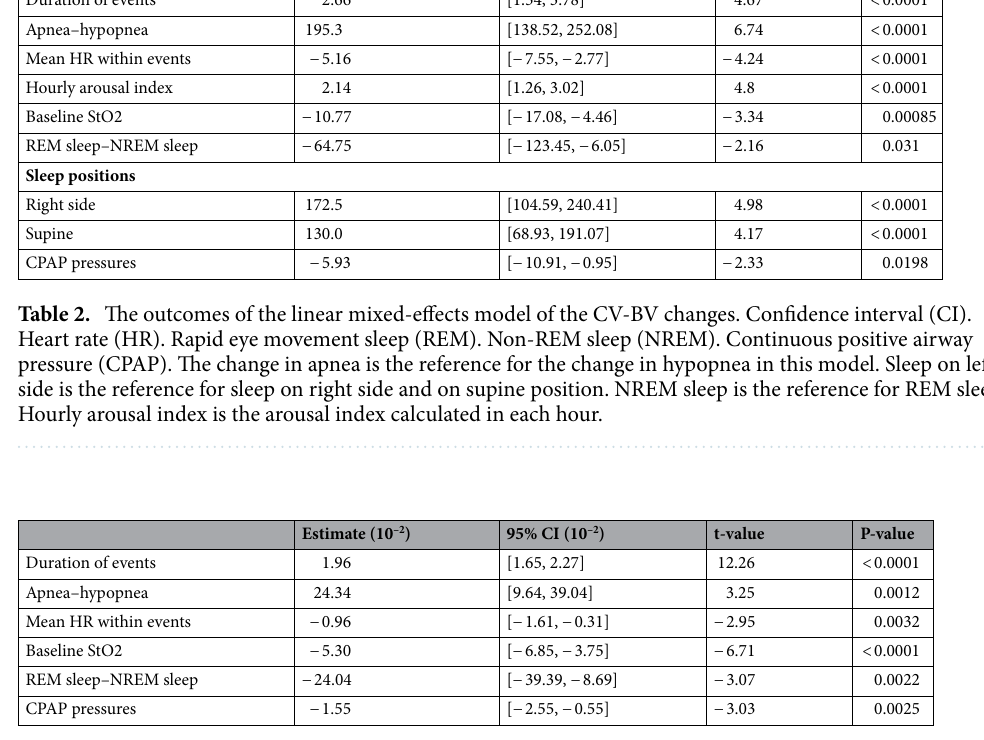
− Table 3. The outcomes of the linear mixed-effects model of the decrease of StO2. Confidence interval (CI). Heart rate (HR). Rapid eye movement sleep (REM). Non-REM sleep (NREM). Continuous positive airway pressure (CPAP). The change in apnea is the reference for the change in hypopnea in this model. NREM sleep is the reference for REM sleep.